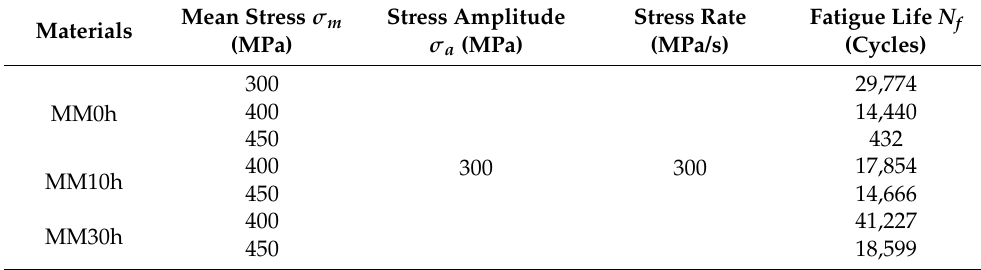
Table 3. Loading conditions and fatigue life of ratcheting-fatigue tests for harmonic-structured SUS316L steels.